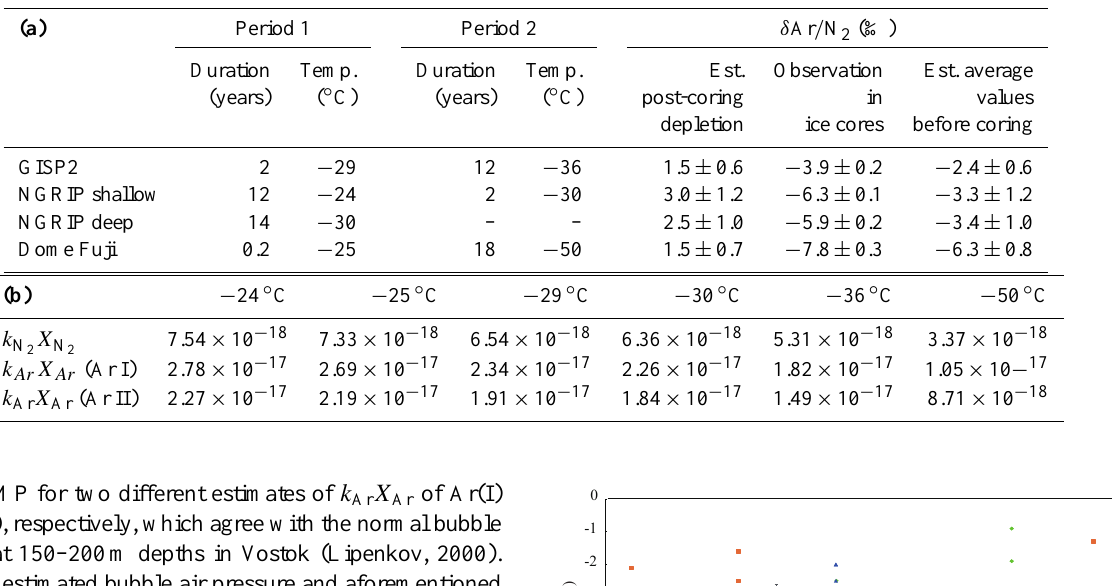
Table 2. (a) Estimated post-coring fractionation on δ Ar / N 2 . The values are averages over the past 2100 years for GISP2 and Dome Fuji. NGRIP shallow and deep are averages of the corresponding depths defined in the text. (b) k N at various temperatures. See also Fig. 2.